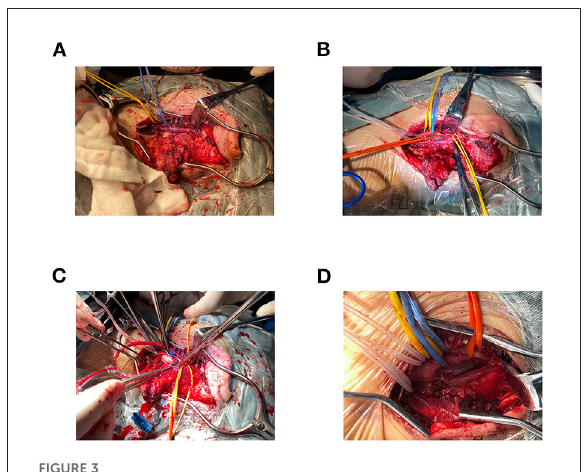
FIGURE3 (A–D) Surgical procedure. The surgical procedure consisted of left carotid artery dissection resection, autologous great saphenous vein interposition grafting, and simple